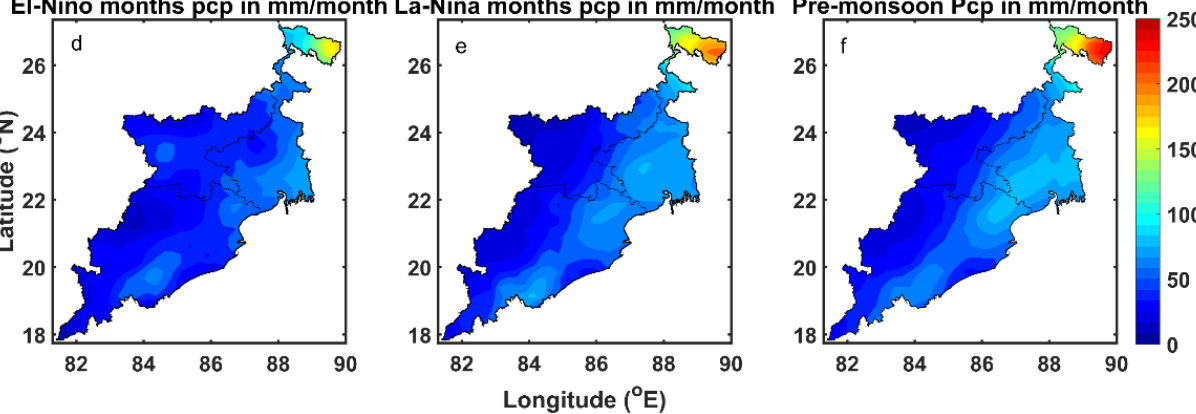
Figure 2. FRD variations during ( a ) El-Niño, ( b ) La-Niña, and ( c ) the total FRD, and accumulated precipitation variations during ( d ) El-Niño, ( e ) La-Niña, and ( f ) total pre-monsoon precipitation from 1998–2014.